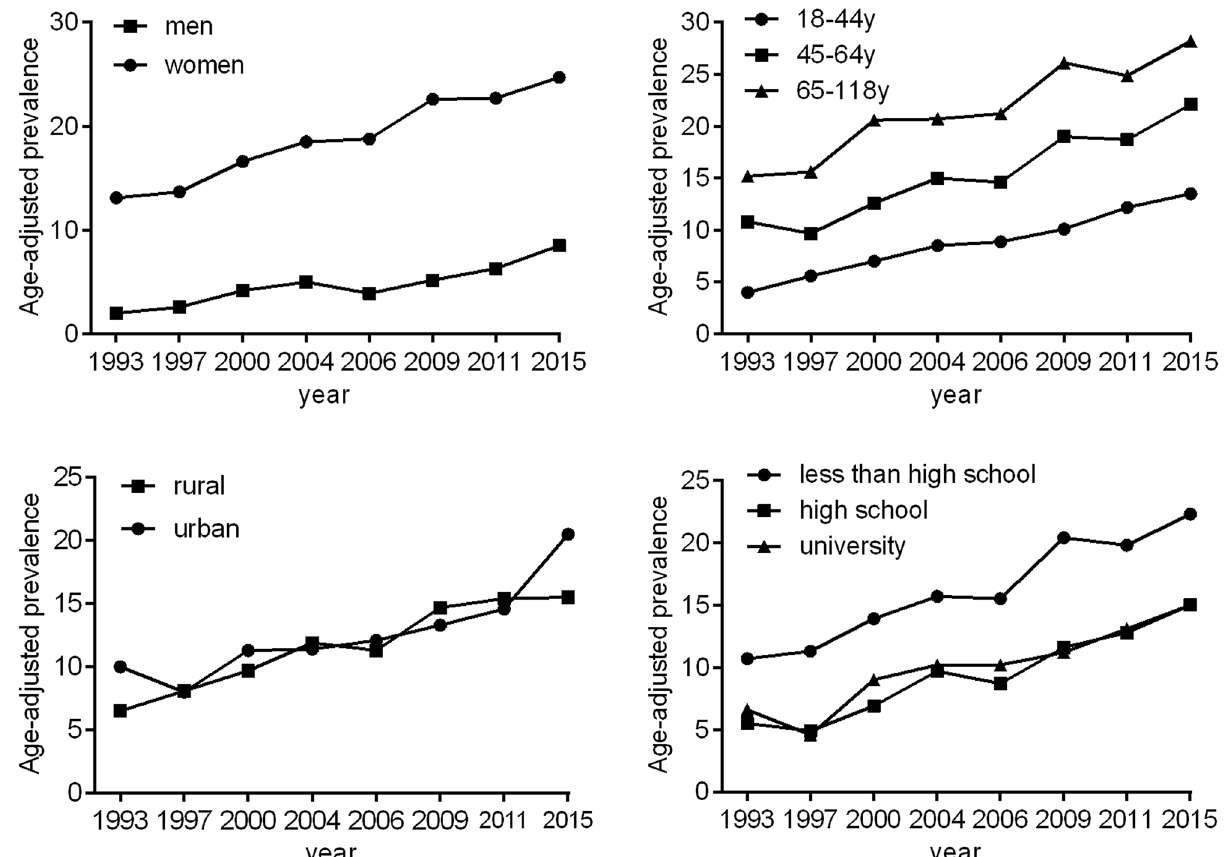
Figure 2. Trends in the age-adjusted prevalence of abdominal obesity among Chinese adults with body mass index < 23 kg/m 2 by sex, age, rural/urban setting, and educational attainment: the CHNS 1993–2015. The estimated prevalence of abdominal obesity was age-standardized to the age distribution of the China population in 2010. The corresponding statistics and P values were showed in the Supplementary Table 4.